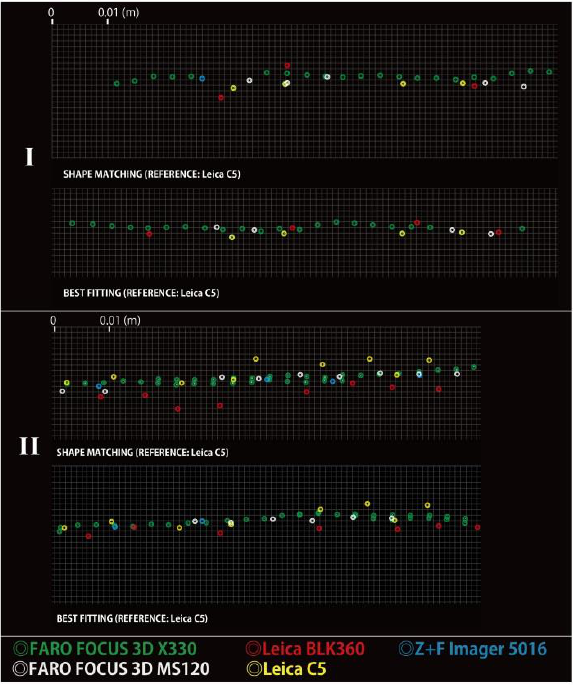
Figure 9: Alignments of Point Clouds (Refference:FARO Focus 3D X330) 5.3